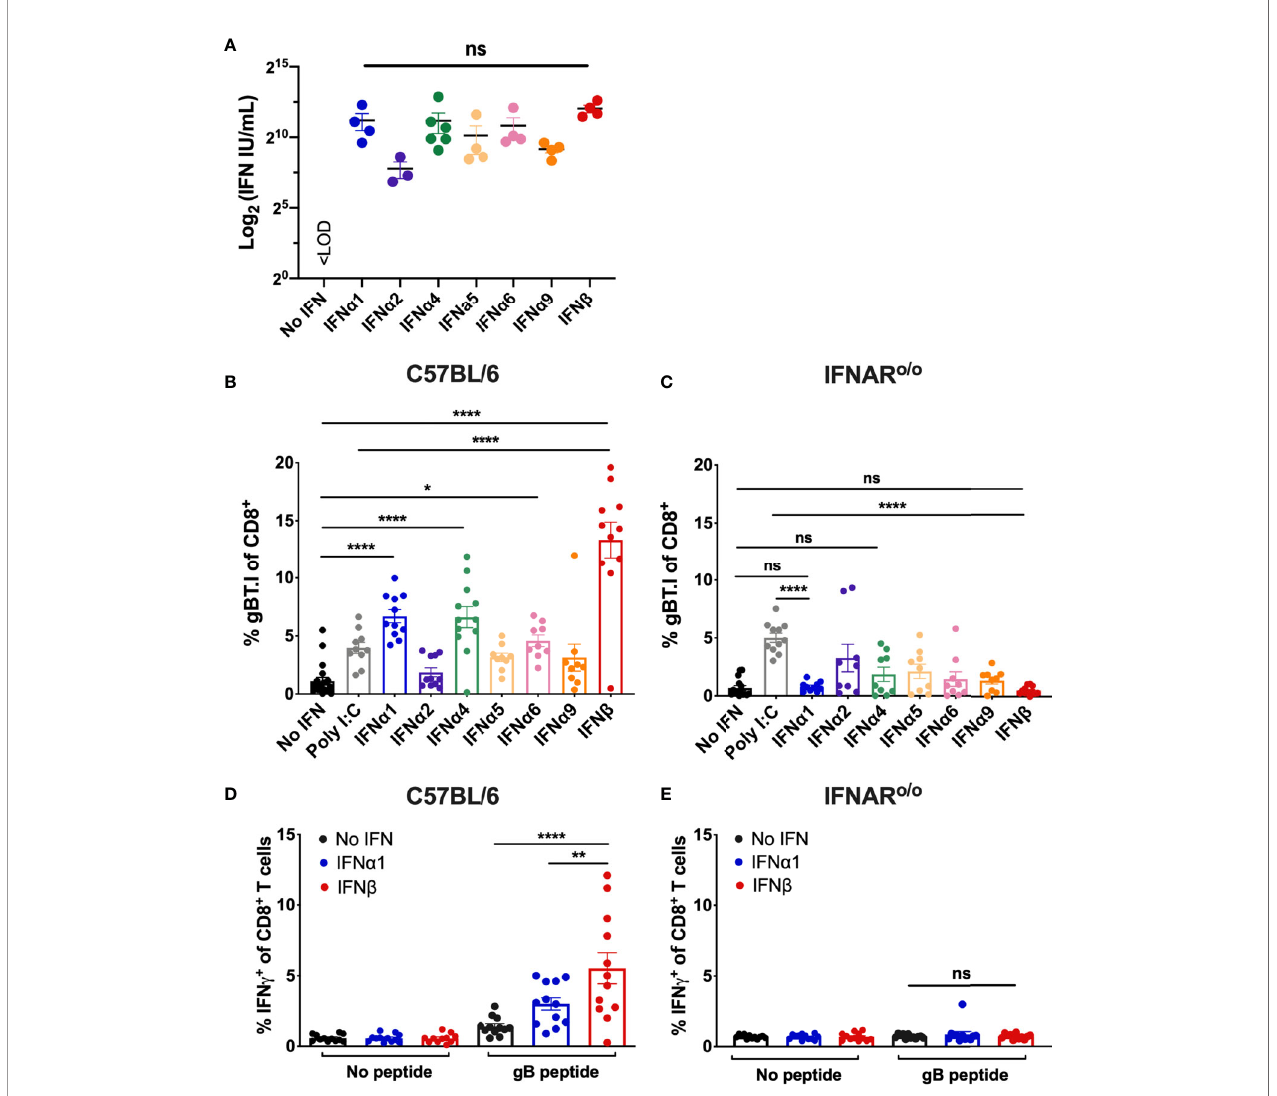
FIGURE 1 | Vaccination with IFN b -secreting B16 cell lines signi fi cantly enhances transgenic and endogenous gB-speci fi c CD8 + T cell expansion. (A) IFN concentration (mean ± SEM) as determined by a cytopathic bioassay comparing supernatants from the engineered B16.Kb loss .gB_IFN cell lines with an IFN a / b standard (n = 3-6). (B – E) Wildtype C57BL/6 or IFNAR o/o mice received 5 x 10 4 naïve gBT.I cells one day prior to vaccination with 2.5 x 10 6 irradiated B16.Kb loss .gB or B16.Kb loss .gB_IFN cells (n = 9-11 per group) with spleens harvested seven days post-vaccination. Expansion of gBT.I cells (B, C) or endogenous IFN g + CD8 + T cells post-restimulation with gB peptide (D, E) was measured by fl ow cytometry (n = 11-12 per group). Data is pooled from 2-4 independent experiments and analysed by one-way ANOVA, ****p < 0.001, **p < 0.01, *p < 0.05, ns, not signi fi cant. Bars represent mean ±